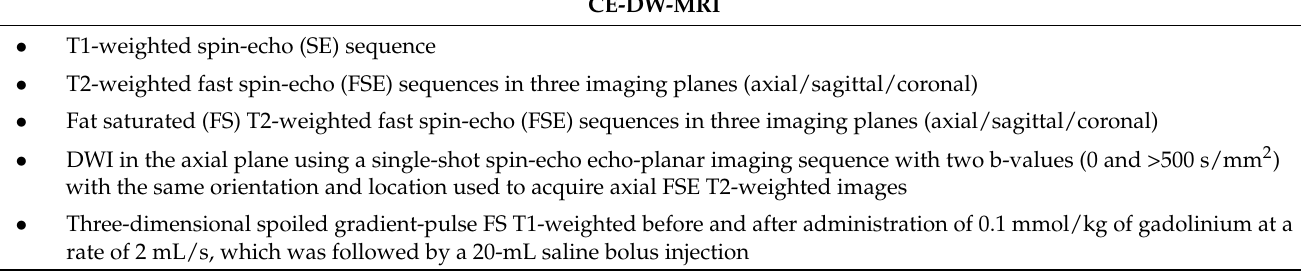
Table 1. Imaging